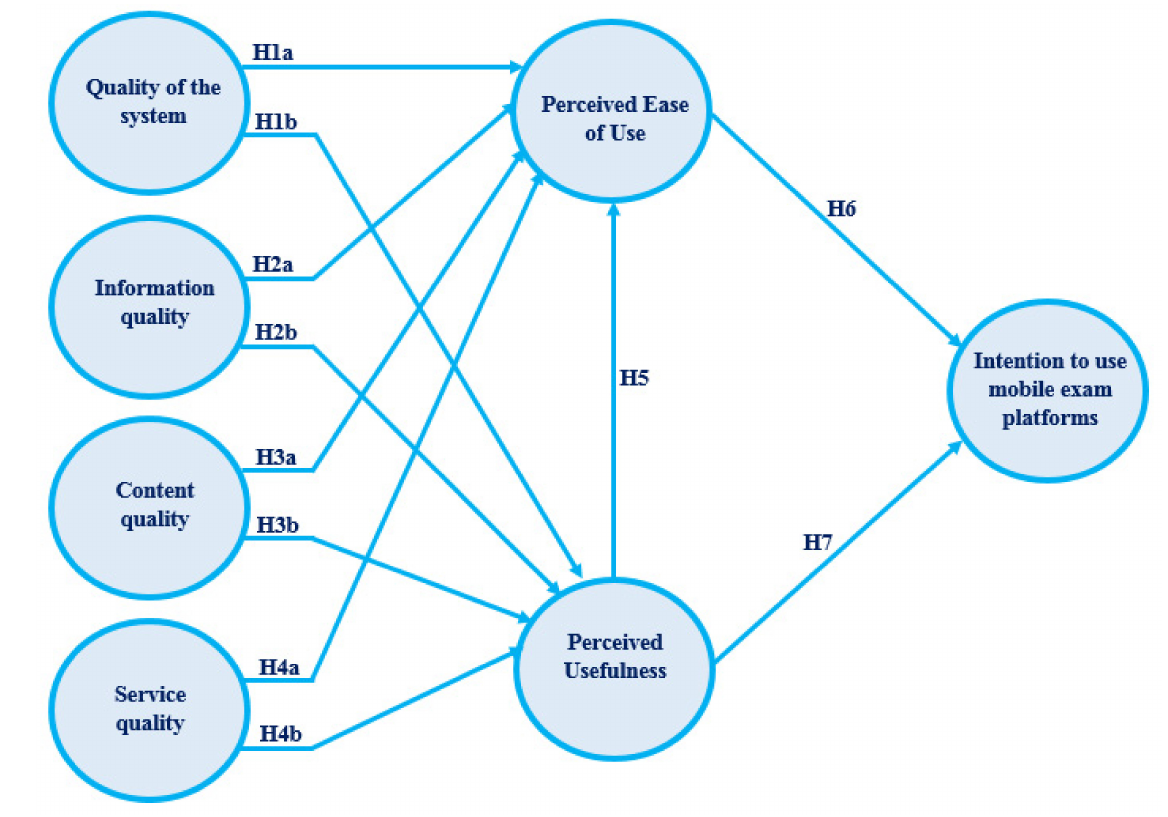
Figure 1. Research